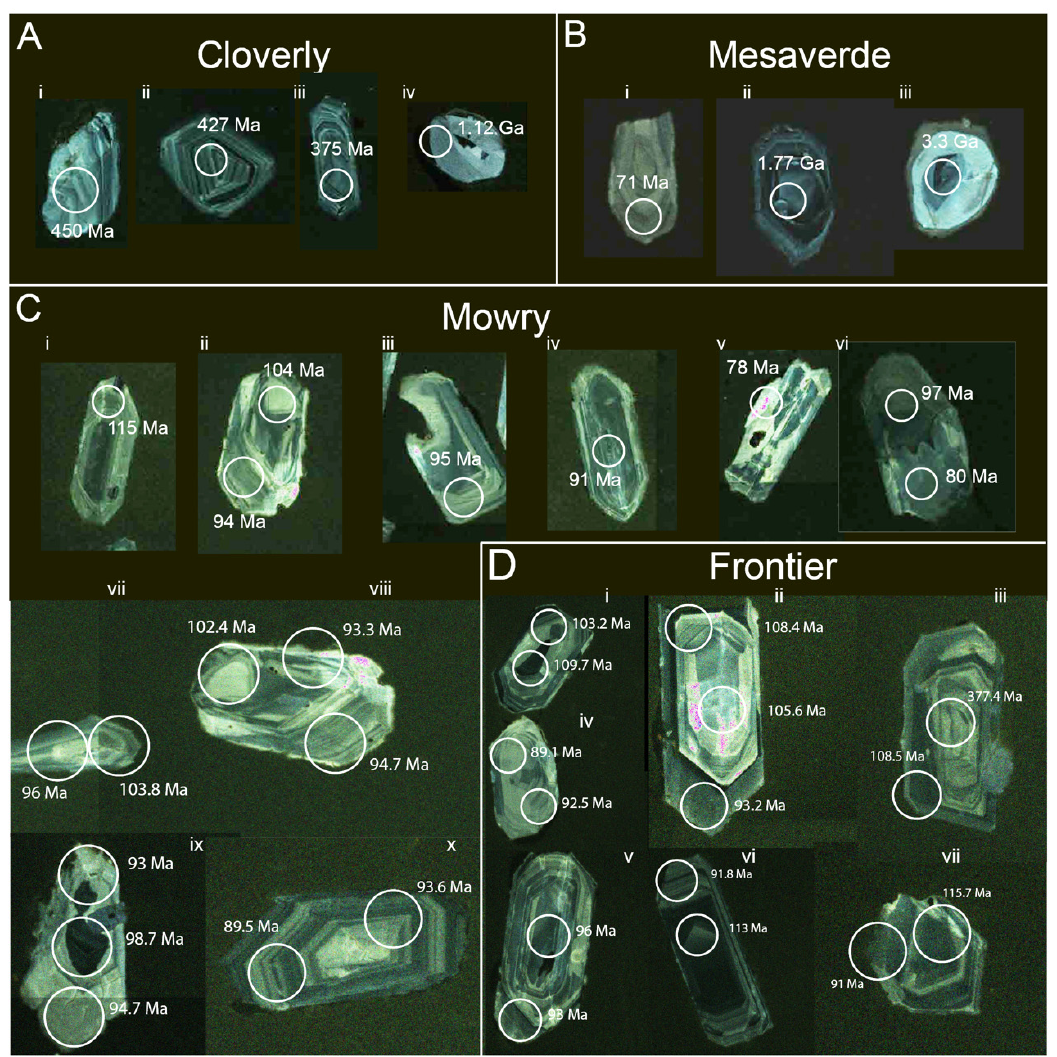
Figure 3. Cathodoluminescence images for selected zircon grains from the Cloverly ( A ), Mowry ( B ), Frontier ( C ) and Mesaverde Formations ( D ). White circles mark the 40-micron target for each analysis with their ages shown. Based on the stratigraphic age constraints and whole-rock bentonite geochemistry [4], zircons can be interpreted as autocrysts (( B ), grain vii and ( C ), grain v ), antecrysts (( B ), grain i ; ( C ), grain i ) and xenocrysts (( A ), grains i – iv ). In grains with two or three analysis targets, the distribution of ages in core and rim domains can be complex. Antecrystic cores may have autocrystic rims (( C ), grains ii and vii ) and xenocrystic cores may have antecrystic rims (( C ), grain iii ). Ages of rims that are younger than the stratigraphic eruptive age may reflect Pb loss during Laramide or younger orogenic events (( B ), grains ii , vi and x ). Zircons with disorganized internal structures including cross-cutting features typically have rim ages significantly younger than the eruptive age, likely reflecting open system behavior during hydrothermal alteration.